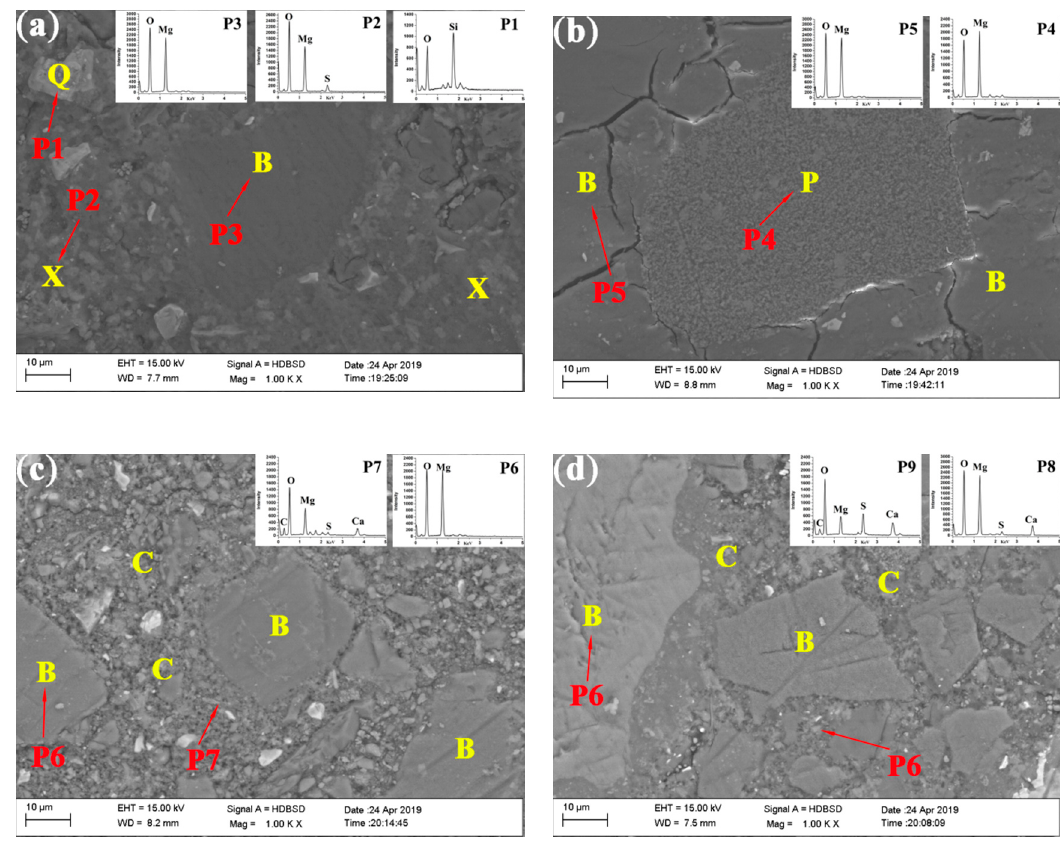
Figure 12. Backscattered electron image of the control and SS30 with CO 2 treatment: ( a ) matrix of control after 28 days air curing; ( b ) matrix of control after 28 days water immersion after air curing for 28 days; ( c ) matrix of SS30 after 28 days air curing; ( d ) matrix of SS30 after 28 days water immersion after air curing for 28 days; X: 517 phase, B: Brucite, Q: Quartz, C: Ca–Mg–C amorphous substance; P: Periclase; P1 is Quartz; P2 is 517 phase; P3, P5, P6, and P8 are Brucite; P5 is Periclase; P7 and P8 are